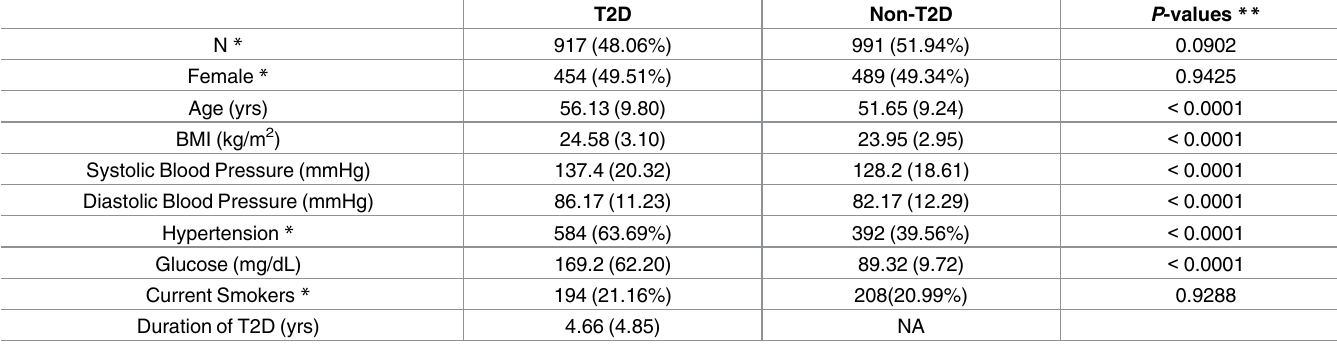
Table 1. Characteristics of the study participants by type 2 diabetes status.